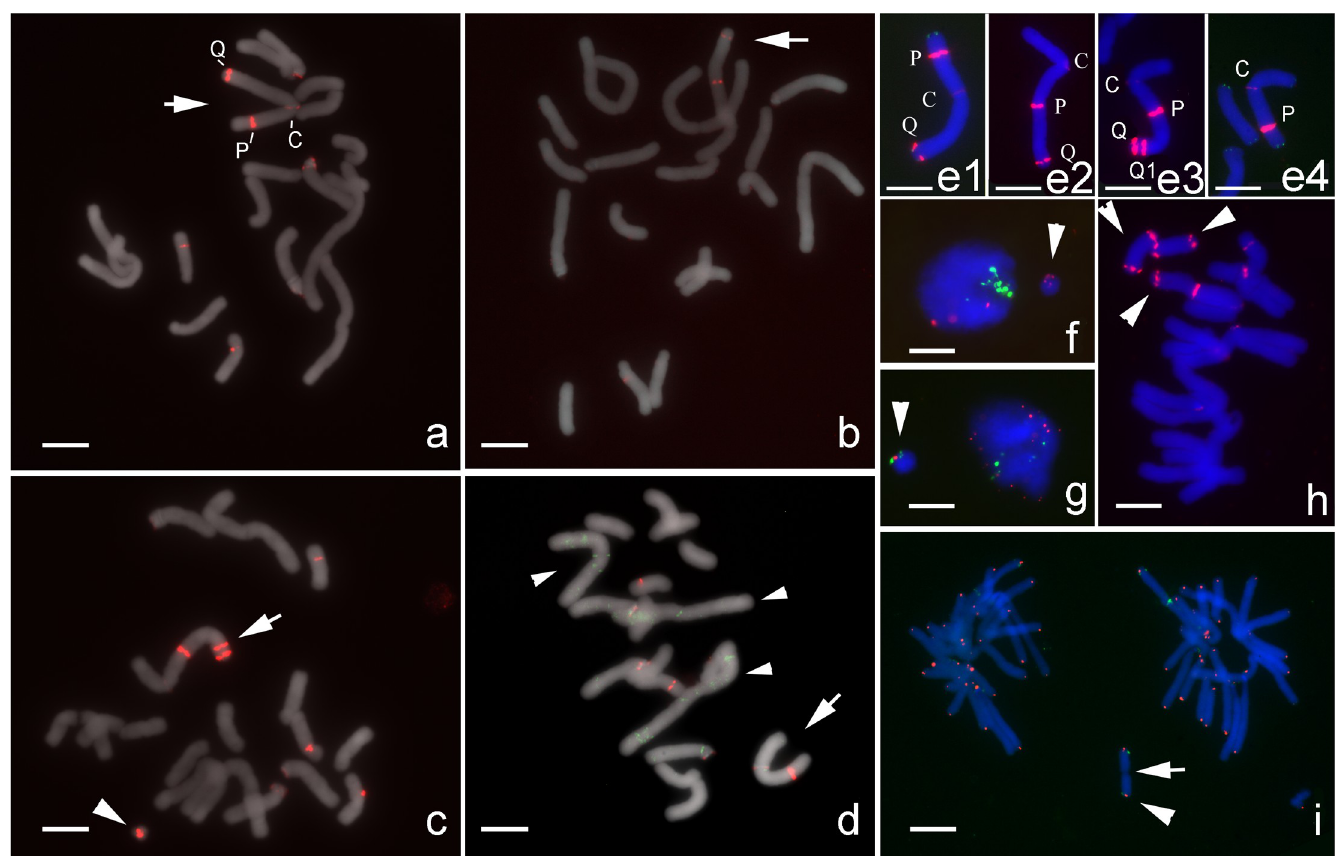
Fig 3. FISH with 5S rDNA detected an inversion and related chromosome structural changes on one M-type chromosome in an artificial hybrid L . aurea × L . radiata (2n = 18, 4M+3T+11A). (Scale bar = 10 μ m). (a) Three FISH signals of 5S rDNA (red) were detected at one M-type chromosome (arrow), including one weak signal near the centromere (C-site) and two conspicuous signals at the intercalary region of the p-arm (P-site) and at the distal end of q-arm (Q-site). (b) Two conspicuous FISH signals of 5S rDNA (red) were detected at the q-arm and one weak signal near the centromeric region on a submetacentric chromosome (arrow). (c) One more conspicuous FISH signal of 5S rDNA (red, Q1-site) was detected near Q-site at the subtelomeric region of a submetacentric chromosome (arrow). Signals of 5S rDNA (red) were visible on the mini-chromosome (arrowhead). (d) Two FISH signals of 5S rDNA (red) were detected at an M-type chromosome (arrow), one conspicuous signal at the intercalary region and one weak signal near the centromeric region. Note that this M-type chromosome is shorter than the other three M-type chromosomes (arrowheads) in the complement. Green signals indicate the locations of LaCenIP-1 repeats which was also used as probe in this FISH experiment. (e) Different FISH signals of 5S rDNA (red) distribution patterns on one M-type chromosome (e1) show the results of a pericentric inversion (e2), amplification of 5S rDNA (e3), and deletion of a distal segment (e4). Green FISH signals in (e4) indicate the telomeres. (f-i) FISH assays characterized the structure of micronuclei in mitotic cells. (f) 5S rDNA (red), 45S rDNAs (green). No detectable 45S rDNA on micronucleus (arrowhead). (g) A micronucleus (arrow) with one 5S rDNA (red) and two telomeres (green). (h) Multiple mini-chromosomes (arrowheads) in a complement with two 5S rDNAs (red) at both distal ends. (i) A mini-chromosome (arrowhead) at anaphase with FISH signals of 5S rDNA (red) and telomere (green) possibly with a centromere (arrow).